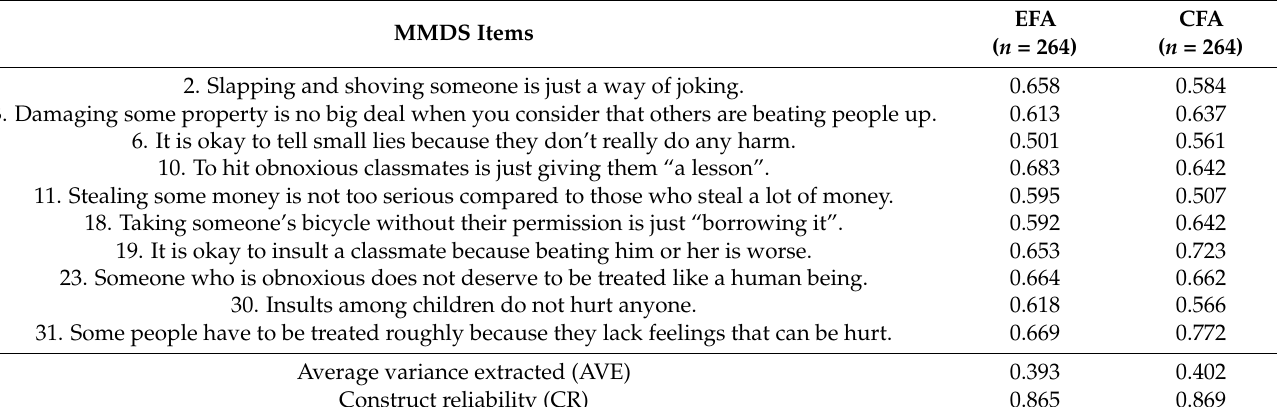
Table 6. Factor loadings and convergence analyses of the 10-item version of the